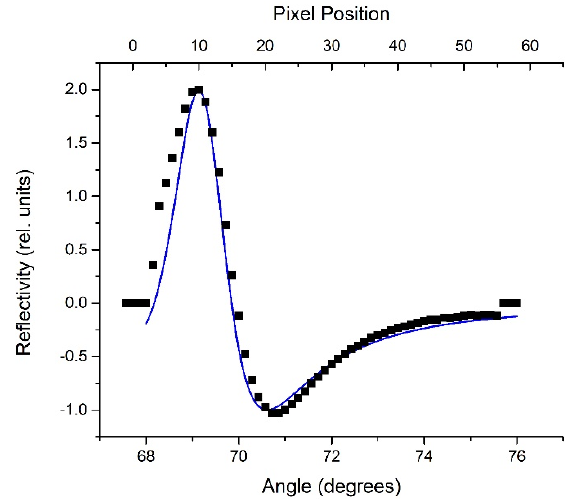
Figure 4. Normalized difference between theoretical SPR curves of the same layer with ± 10% variation of thickness (blue line) and normalized difference between measured SPR curves at pH 7.4 and 6 on a C1 SPR chip (black points).